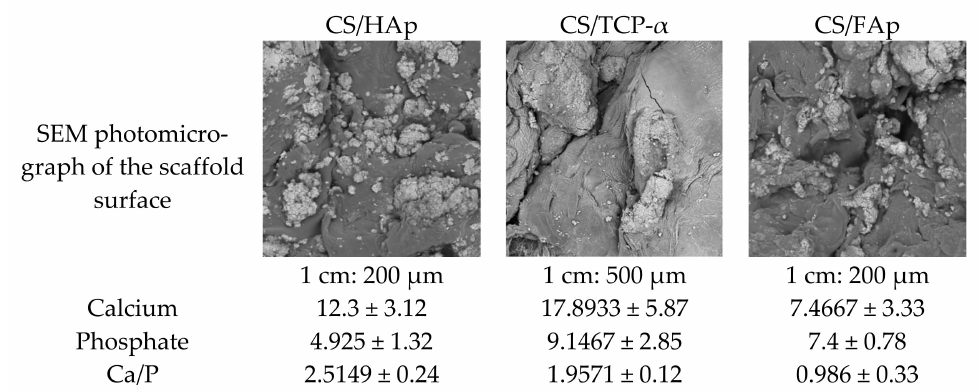
Figure 12. SEM-EDX analysis for the scaffolds showing the highest Ca/P values in CS/HAp followed by CS/TCP- α and CS/FAp.